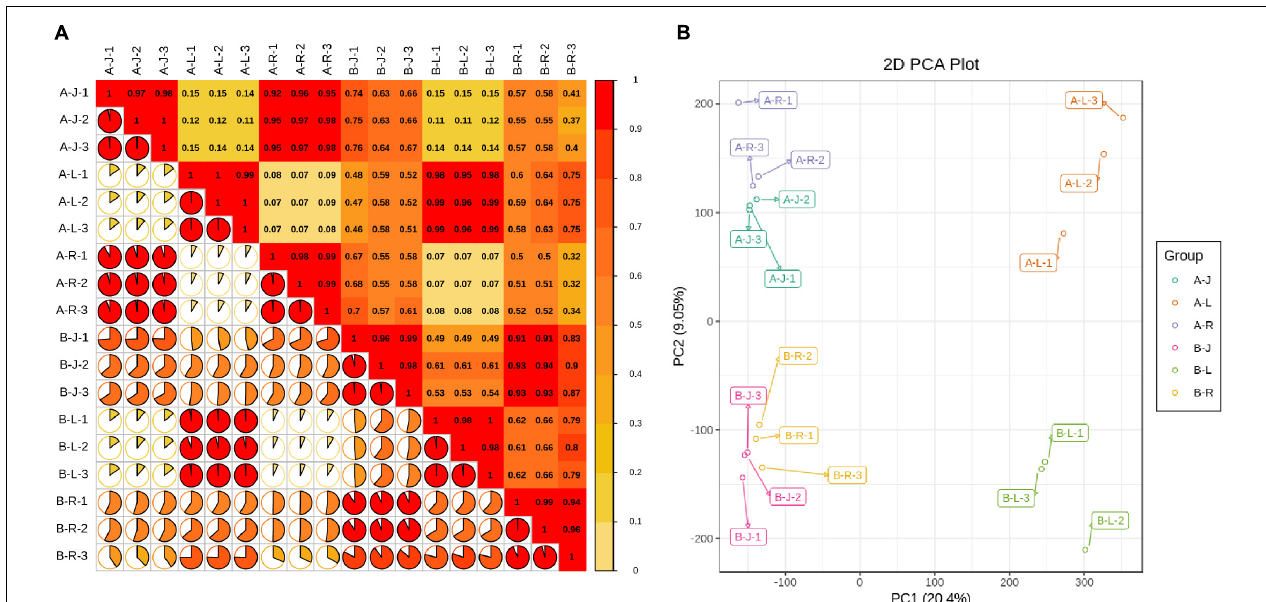
FIGURE 1 | Panax notoginseng transcriptomic parameter analyses. (A) Pearson’s correlations between inflorescence-removal treatment and non-inflorescence-removal control samples; and (B) Principle component analysis of expressed genes.